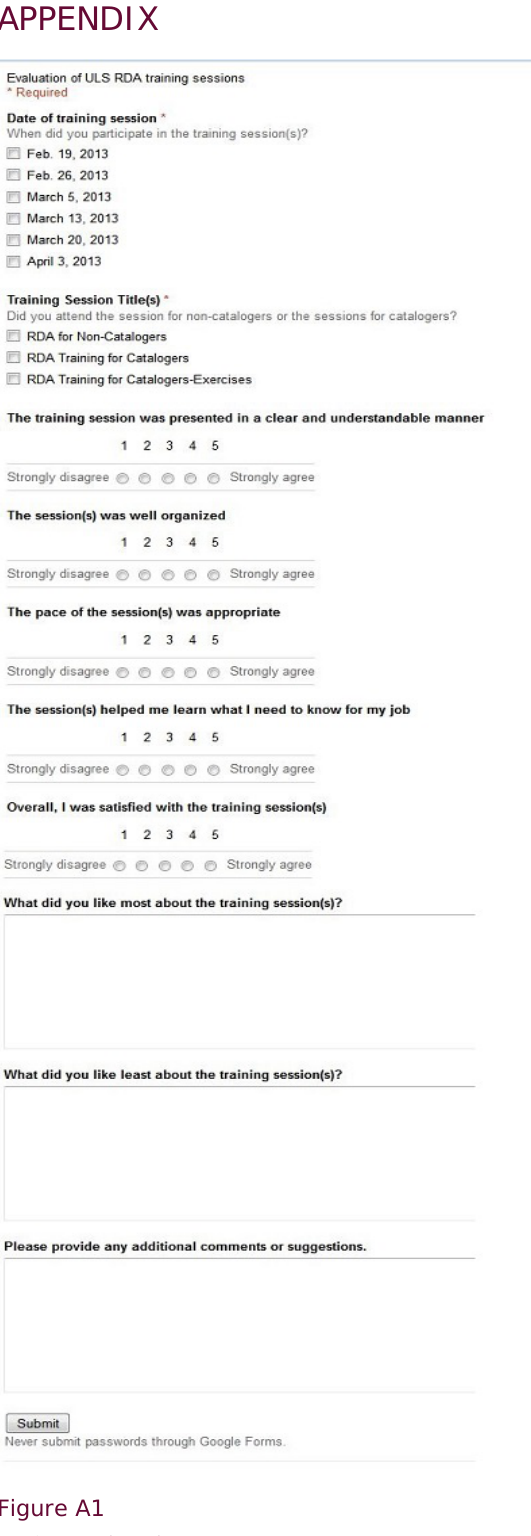
Evaluation form for ULS RDA training